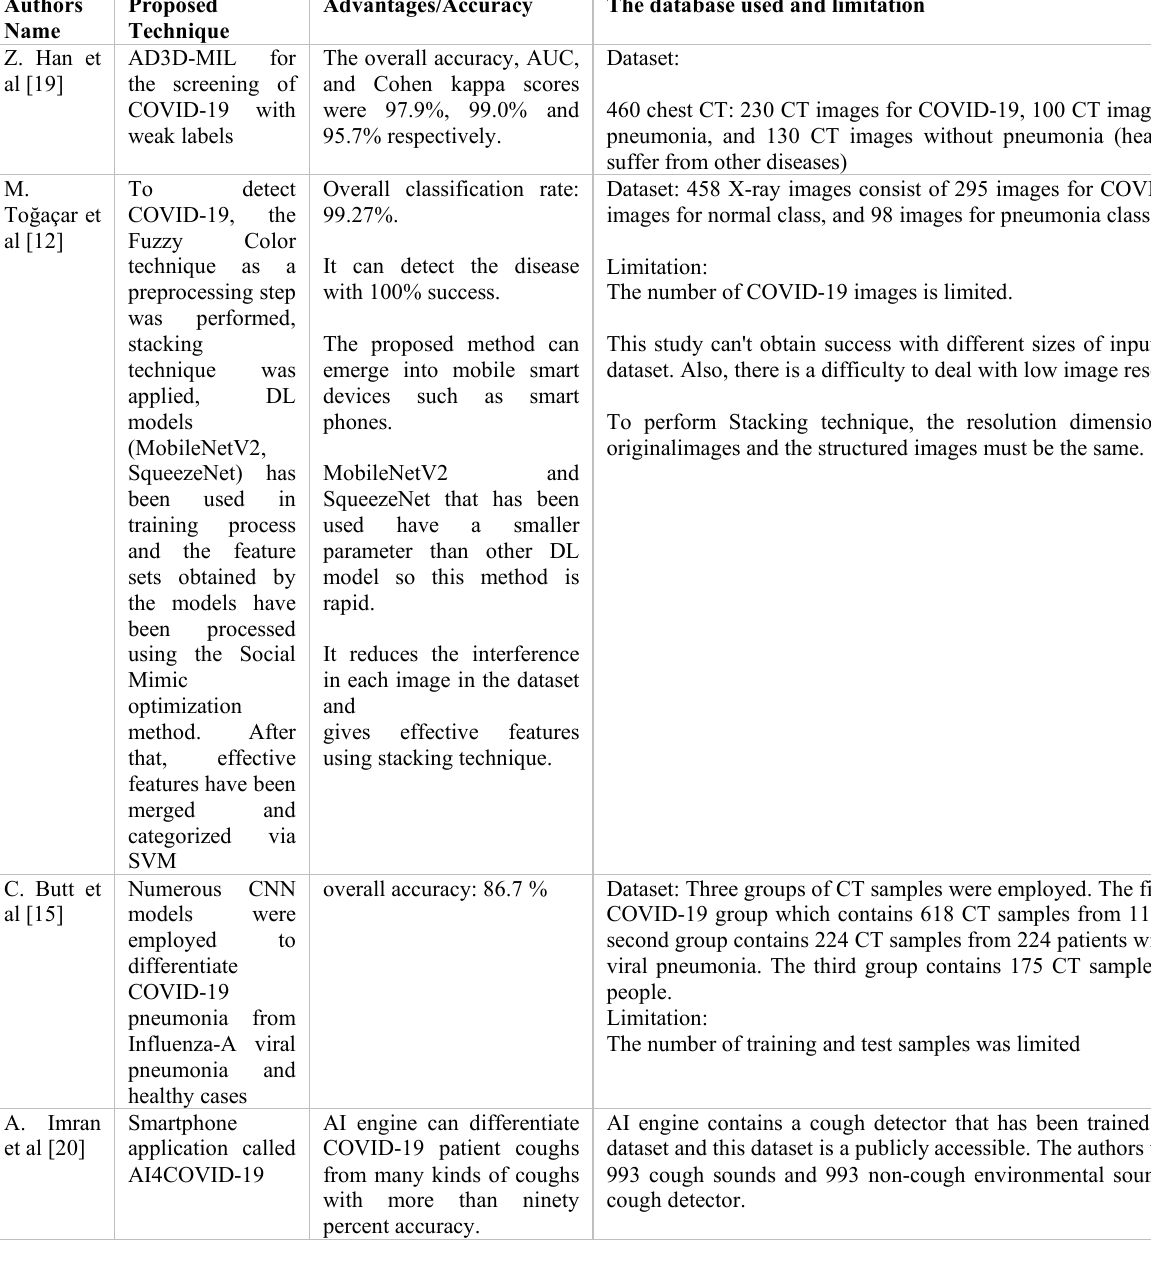
Table 1. Existing ML approaches for diagnosis and detecting